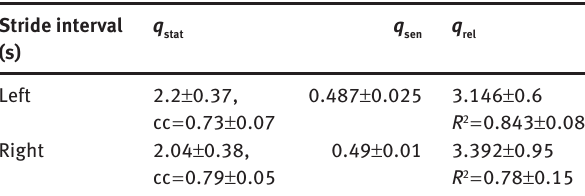
Table 4: Tsallis q -triplet for stride intervals corresponding to a healthy control